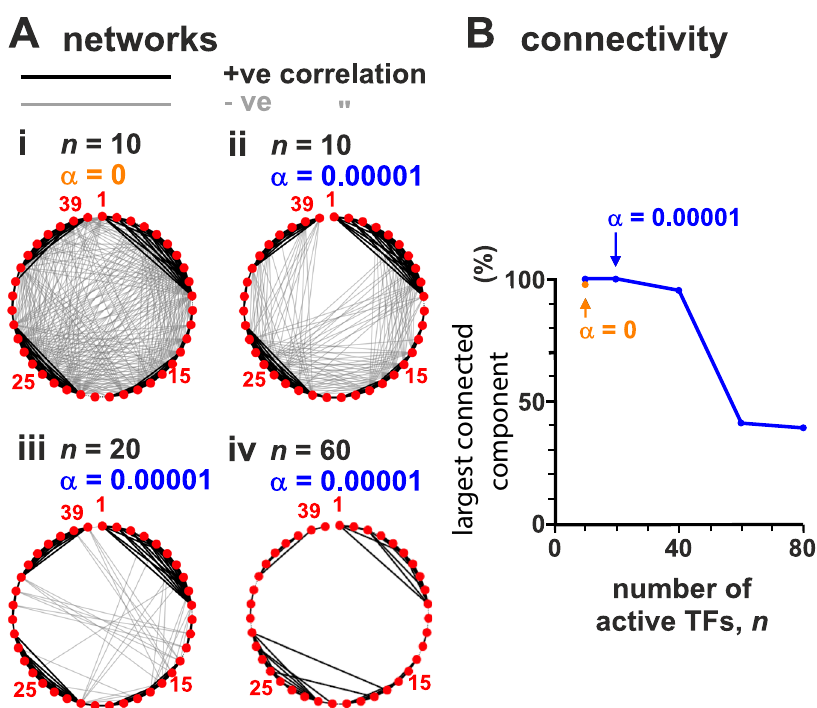
Fig. 3 Regulatory networks formed by TU beads are percolating at low TF concentrations. Simulations (as Fig. 1, with ≥ 800 simulations/condition) with different average numbers of active TFs ( n ) and switching rate ( α ). Networks were constructed by calculating the Pearson correlation between the transcription time series for all pairs of TUs; nodes represent each of the 39 TUs and edges are placed between nodes where there is a signi fi cant correlation (>0.15 in absolute value, corresponding to p < 10 − 6 ; two-sided Student ’ s t -test). A Effect of TF concentration and switching. Thirty-nine nodes are shown around the perimeter, and thick black and grey lines denote positive and negative correlations between transcriptional activities of bead pairs. B Effect of n on the fraction of nodes in the largest connected